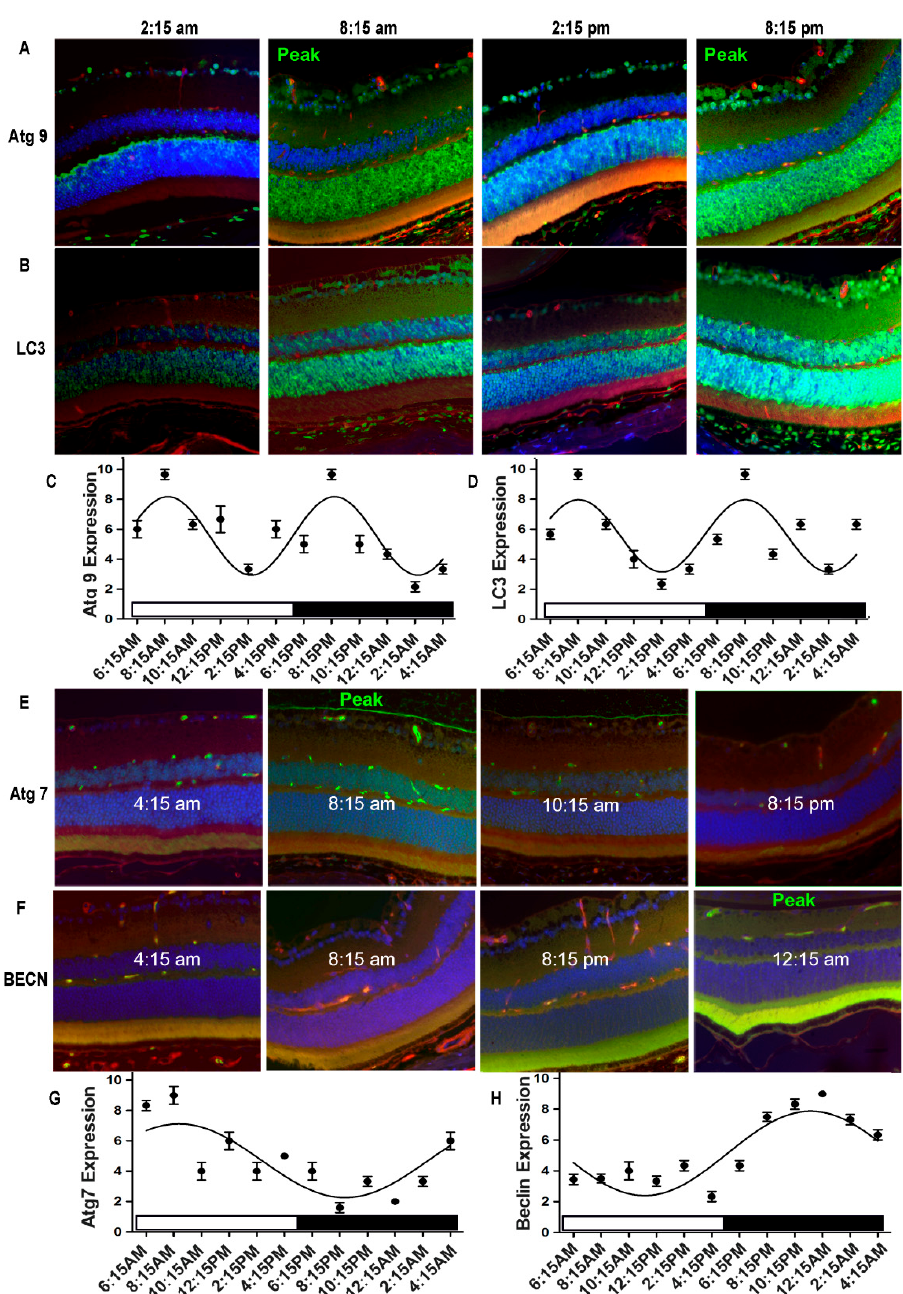
Figure 1. Autophagy proteins exhibited diurnal expression / localization in normal mouse neural retina. Retina were harvested every 2 h over a 24 h time period. Antibodies for autophagy proteins (ATGs) ATG9, Microtubule-associated protein 1A / 1B-light chain 3 (LC3), ATG7 and Beclin1 (BECN) were used to detect respective protein expression (green) in the retina, Tetramethylrhodamine (TRITC) agglutinin for vessels (red) and DAPI (blue) shows nuclear staining. Distinct diurnal rhythmic patterns of the autophagic proteins Atg9 and LC3 expressions ( A , B ) revealed a biphasic diurnal cycle (12 / 12 h), with peaks at 8:15 AM and 8:15 PM and lowest levels at 2:15 AM and 2:15 PM ( C , D ). Atg7 and Beclin1 (BECN) expressions ( E , F ) were on a monophasic 24 h cycle. Atg7 expression peaked at 8:15 AM and lowest levels were at 10:15 AM. The peak of Beclin1 expression was at midnight and lowest levels were observed during the late morning ( H ). All animals were maintained in a standard 12 / 12 h light / dark phase with lights ON at 6:00 AM and lights OFF at 6:00 PM. The error bars in the diurnal plots represent the mean + SEM and diurnal oscillation had a p -value less than